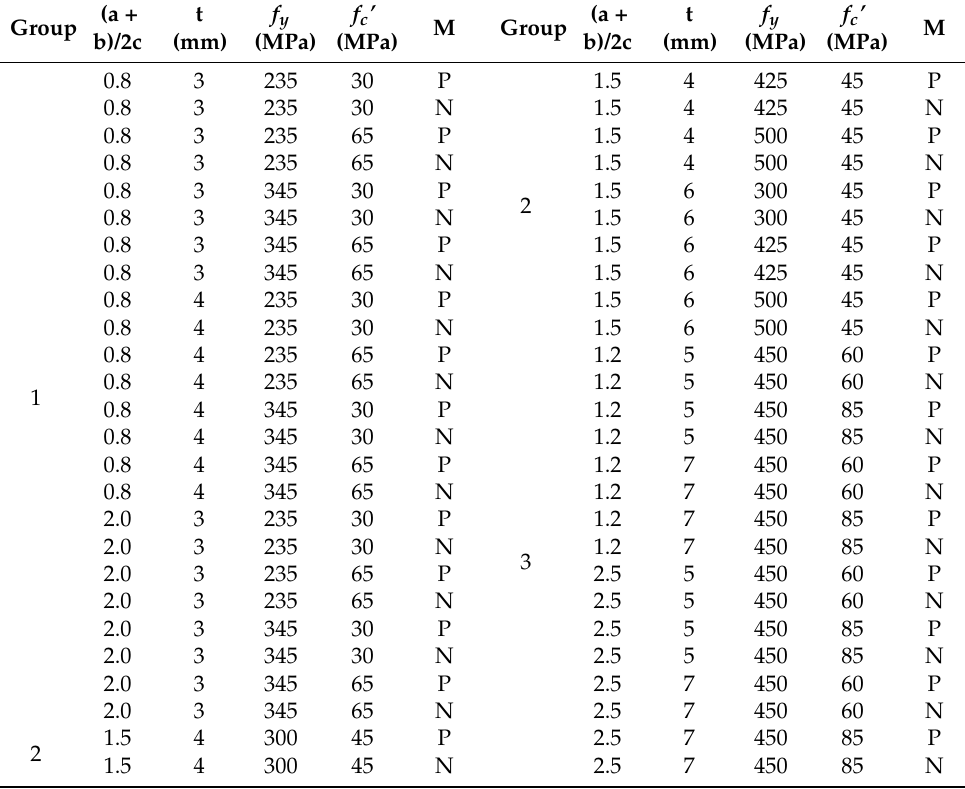
Table A1. Details of the geometric and material properties of the numerical models (P and N denote positive and negative bending moment,